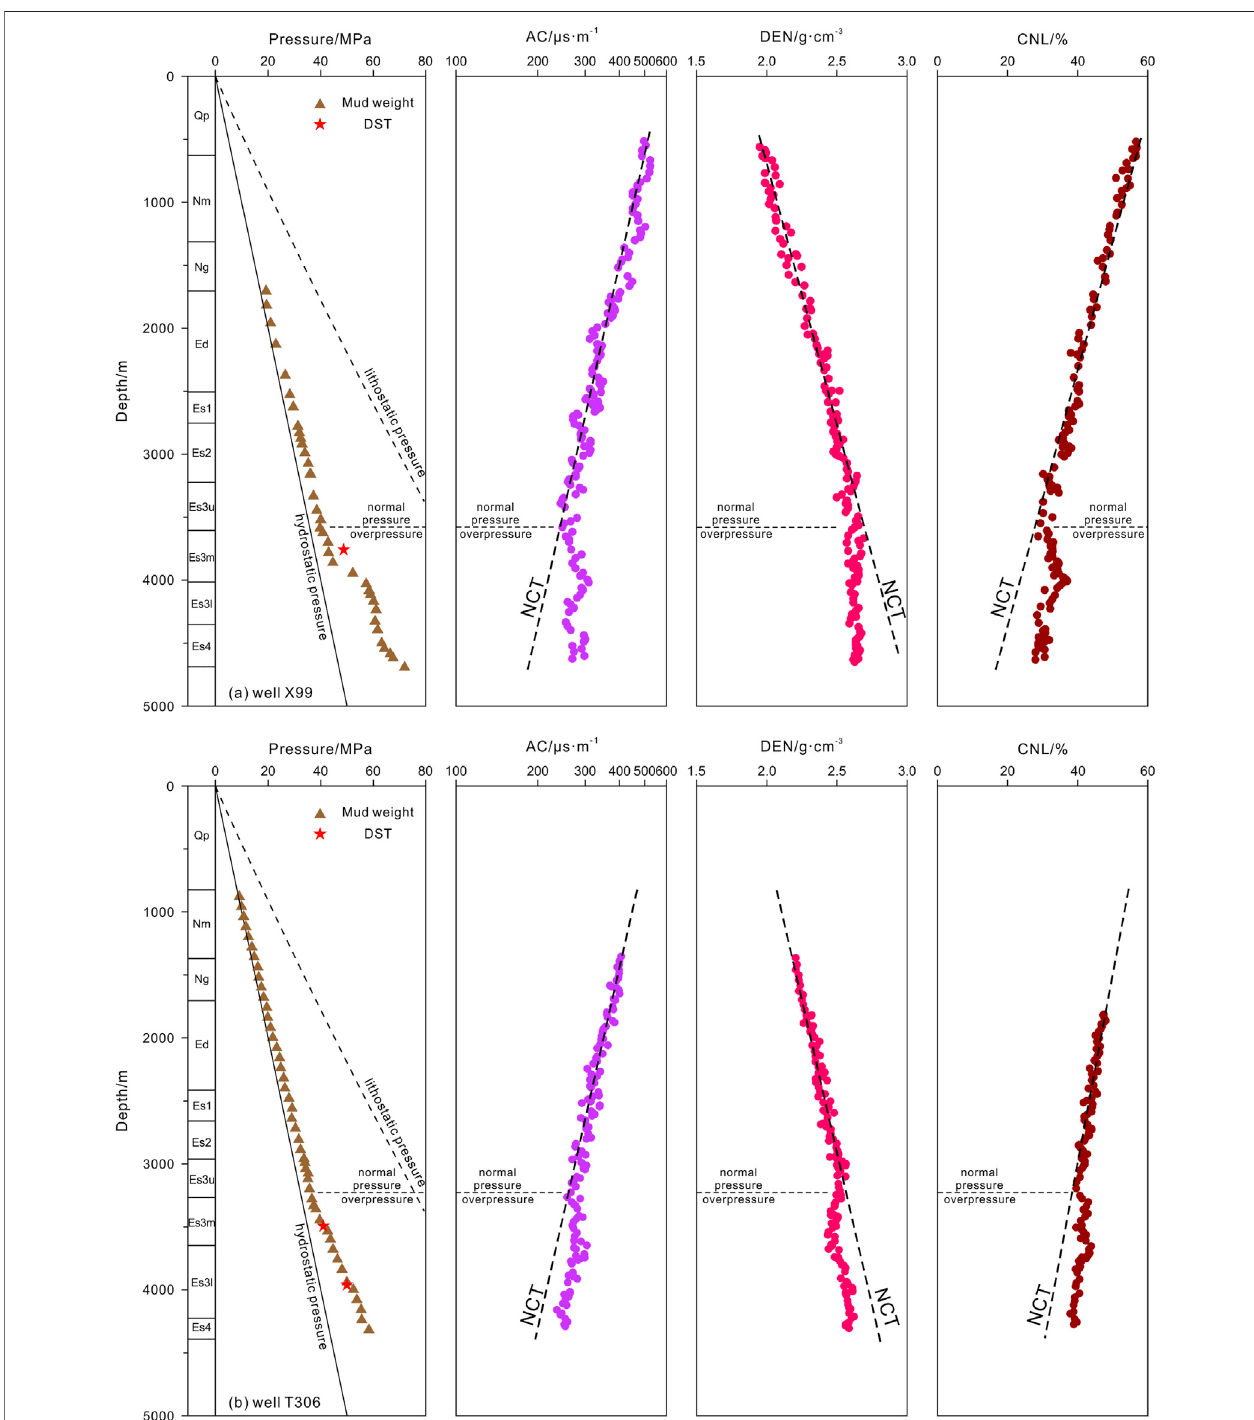
FIGURE 6 | Pro fi les of the well logging parameters of mudstone to overpressure of (A) well X99 and (B) well T306, including mud weights and DSTs data, sonic transit time (AC), density (DEN), and neutron (CNL) logs. The well locations are shown in Figure 1 .